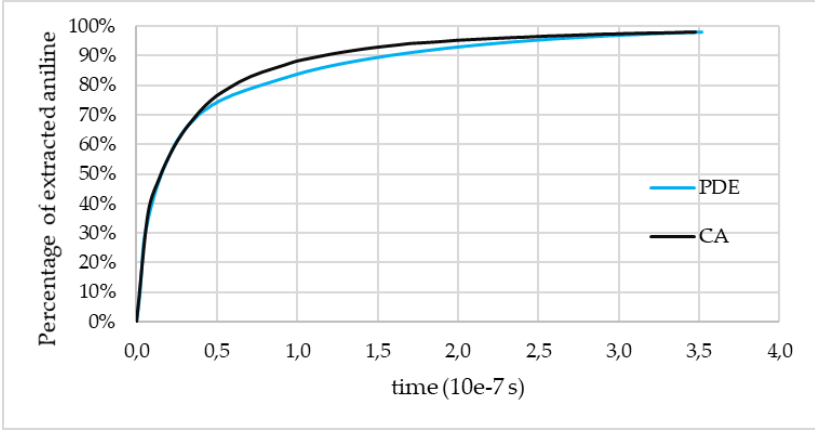
Figure 9. Kinetics of the aniline extraction from a porous catalyst: PDE — experimental data, cellular automata (CA) — calculated.